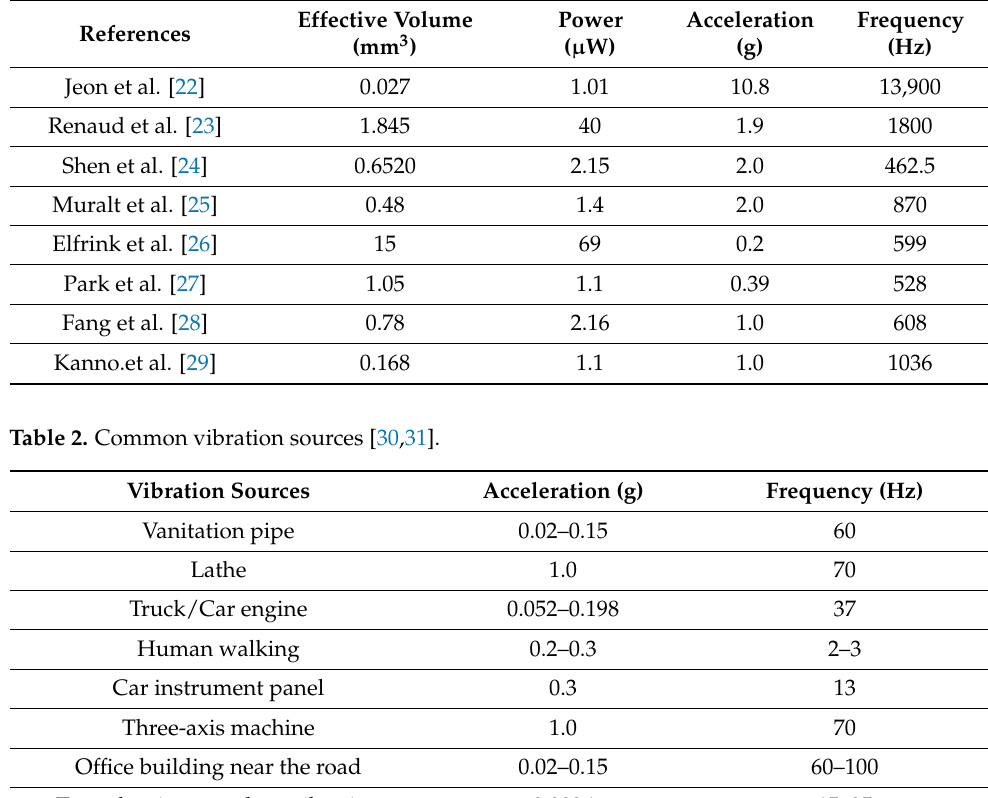
Table 1. Typical micro piezoelectric vibration energy harvesters (PVEHs).